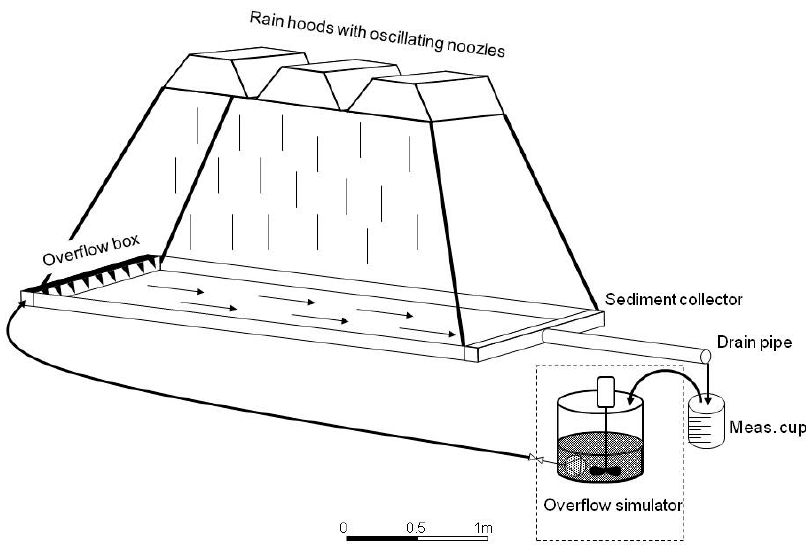
Figure 2. The Freiberg rainfall simulator [17].